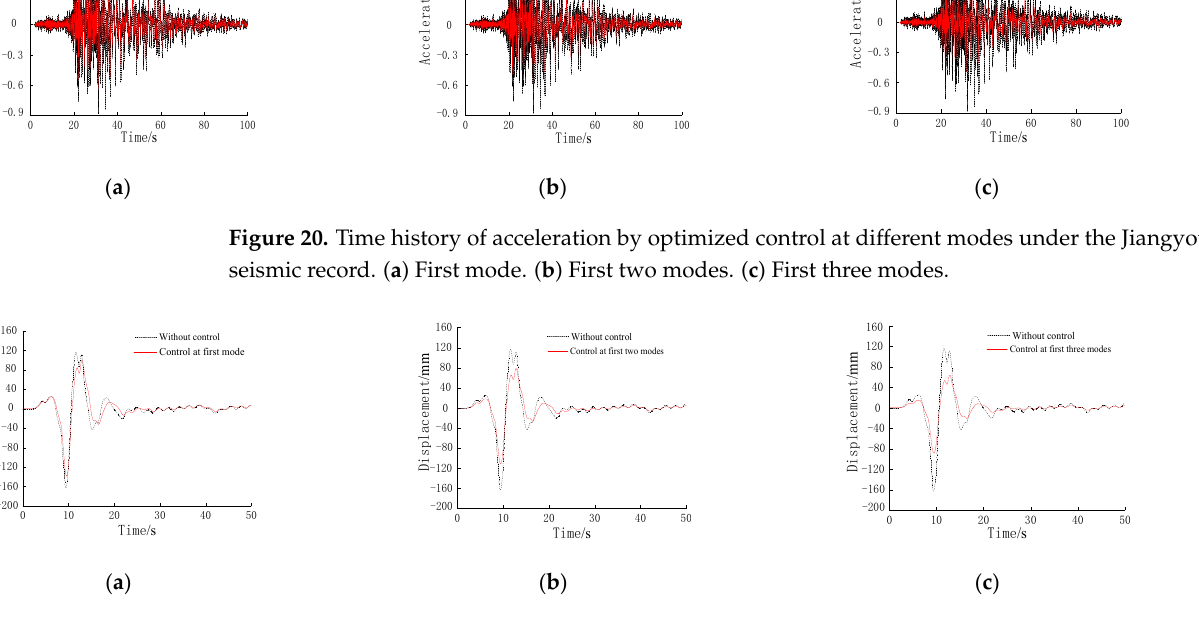
Figure 21. Time history of displacement by optimized control at different modes under the artificial wave. ( a ) First mode. ( b ) First two modes. ( c ) First three modes.